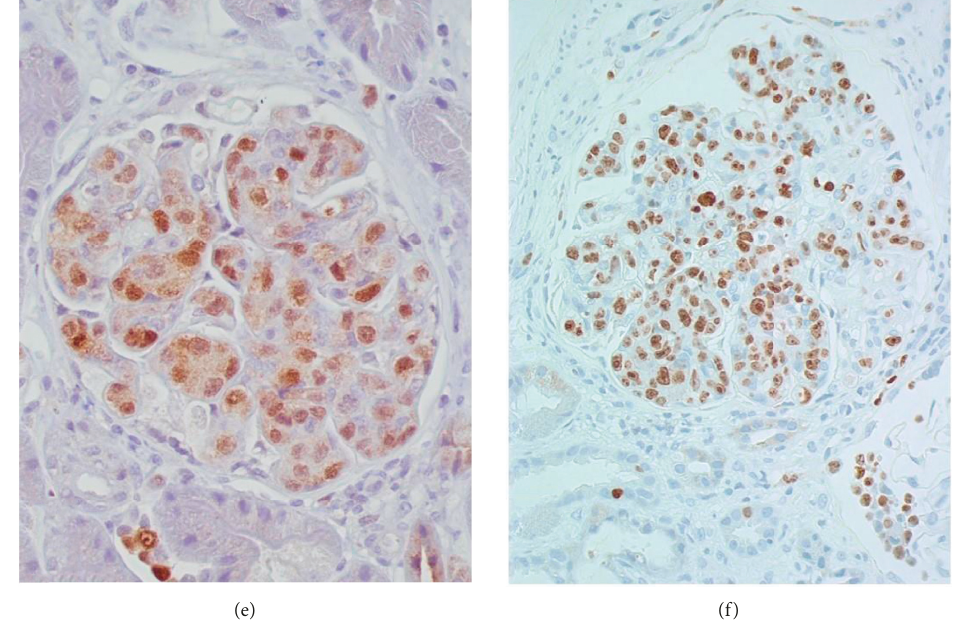
Figure 1: Intraglomerular lymphoma cells. (a) PAS large atypical cells obstructing the glomerular capillary lumen (magnification 600x). (b) Intracapillary glomerular cells positive for CD45 (magnification 400x). (c) Intracapillary glomerular cells negative for CD20 (magnification 400x). (d) Intracapillary glomerular cells positive for CD79A (magnification 400x). (e) Intracapillary glomerular cells positive for MUM-1